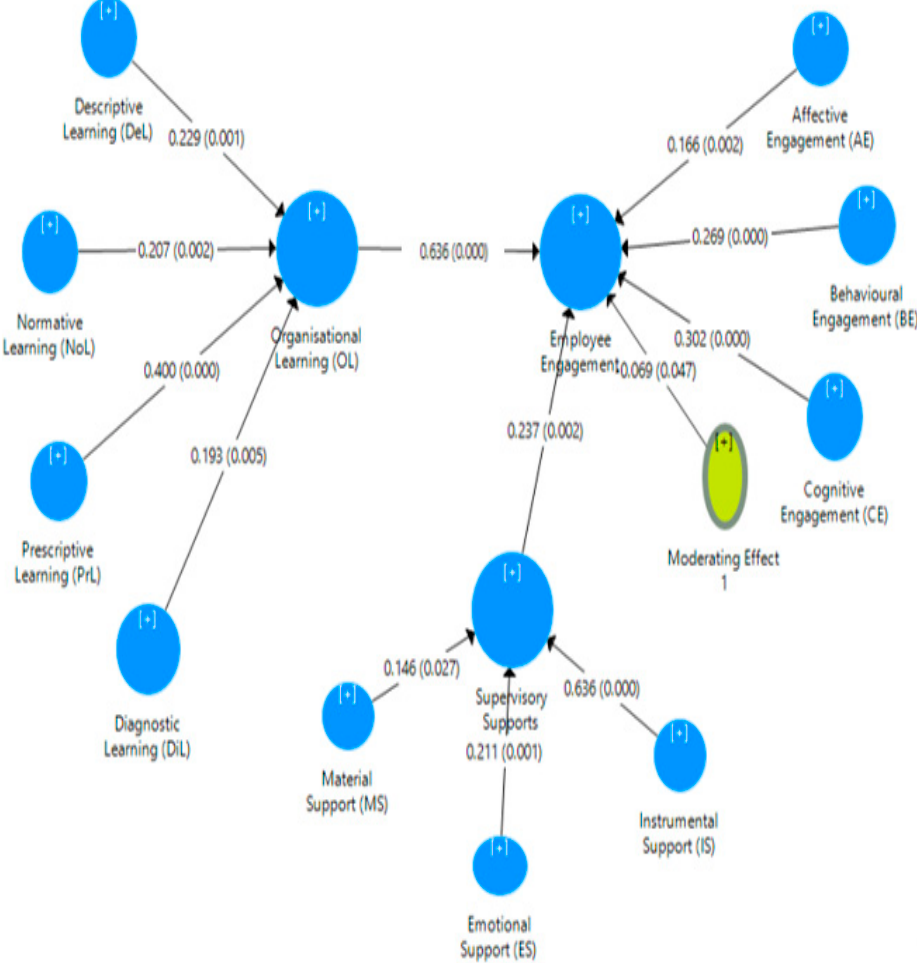
Figure 1. PLS Bootstrapping model with β and p values of supervisory (material, emotional and instrumental) supports do not moderate the relationship between organisational learning and em- ployee engagement in the pharmaceutical